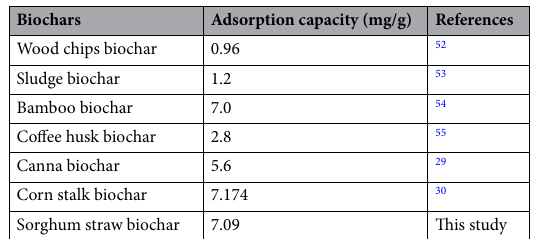
Table 4. A comparison of the adsorption capacities of other adsorbents for ammonium.